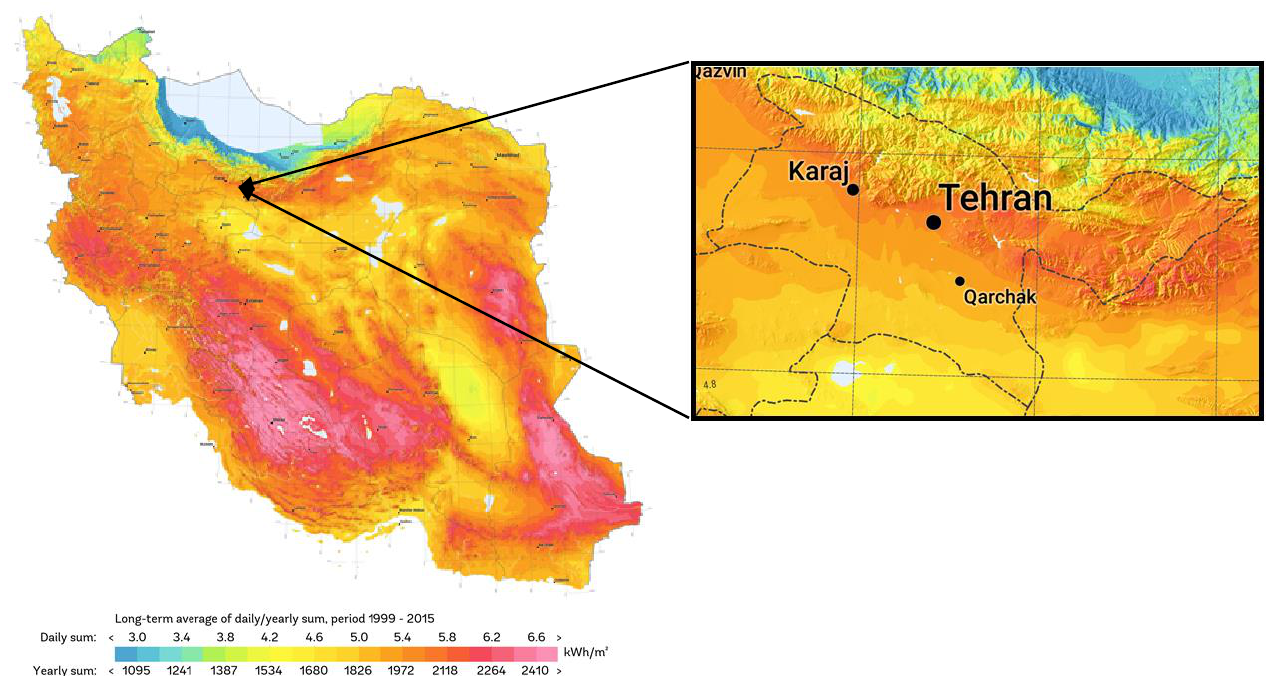
Figure 1. Iran solar radiation annual means (source: Direct normal irradiation,